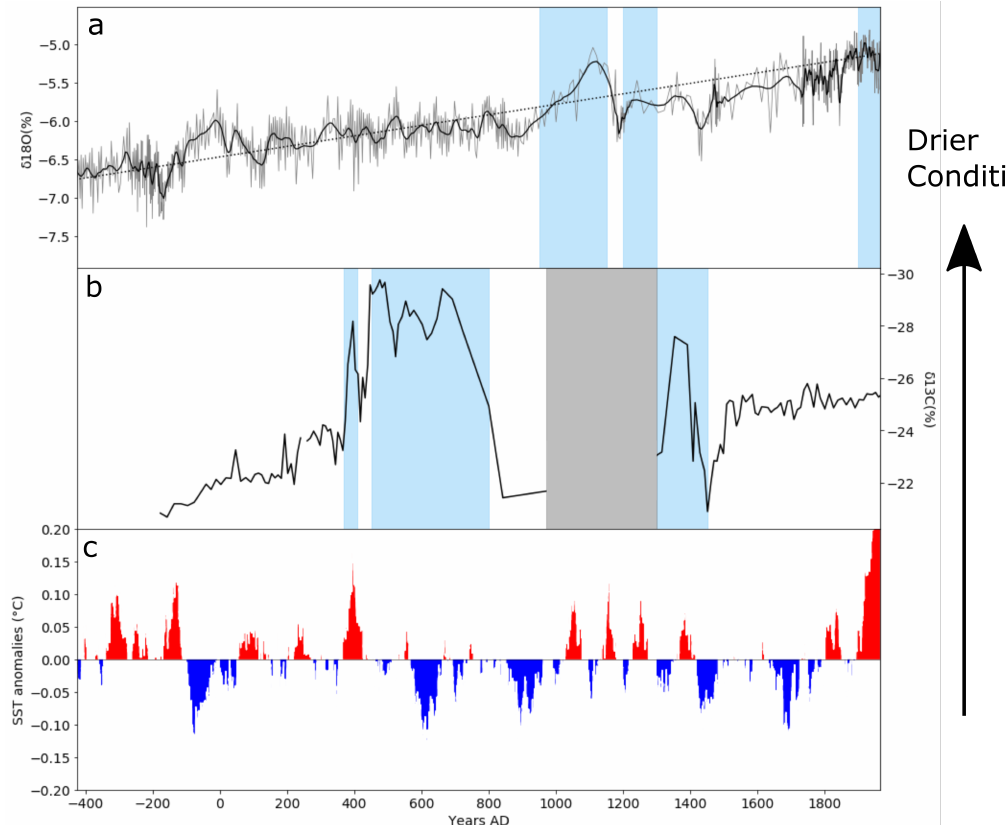
Figure 4. A plot comparing climate proxies and modelled sea surface temperature (SST) anomalies from 425 BC to 1964 AD. ( a ) Stalagmite δ 18 O values [31], the grey lines represents the raw data which is overlaid by black smoothed data using the Savitzky–Golay filter (R 2 = 0.25). ( b ) Sediment core δ 13 C values [30]. ( c ) Modelled SST for Niño region 3.4 spanning from the TraCE-21ka simulation (sourced from Earth System Grid: https://www.earthsystemgrid.org/project/trace.html). Blue shaded areas represent drought periods discussed by the papers associated with each proxy. The grey shaded area shows the hiatus in the sediment core. Trendlines are present to show the overall gradual change to a drier